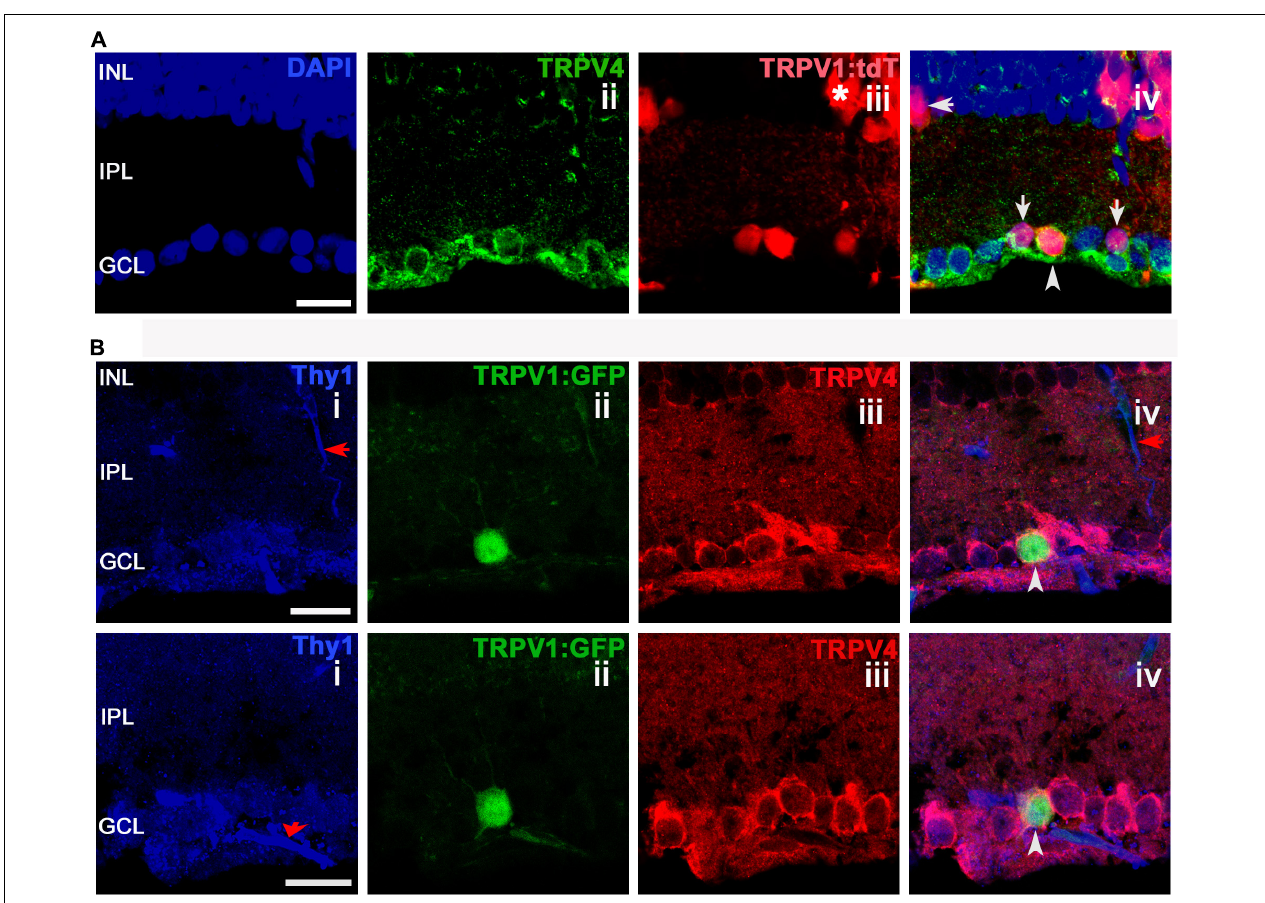
FIGURE 4 | TRPV1 expression in RGCs but not amacrine cells overlaps with TRPV4-ir. Confocal microscopy, vertical sections from the mouse retina. (A) TRPV1Cre/Ai9 retina labeled for DAPI, TRPV4, and TRPV1. TRPV1:tdTomato is expressed in cell somata localized in ganglion cell layer (GCL), inner nuclear layer (INL), and in a subset of putative Müller cells (asterisk). RGC that colocalizes TRPV1 and TRPV4 is marked by an arrowhead in panel iv. Arrows mark putative (small-diameter) amacrine cells in RGCL and IPL that are TRPV4 − . (B) TRPV1Cre/Ai3 section showing a TRPV1 + cell labeled by the GFP reporter. The cell was immunopositive for TRPV4 and Thy1. Red arrows donate blood vessels. Pictures were obtained from two optical sections with a thickness of 1 µ m. Scale bars = 20 µ